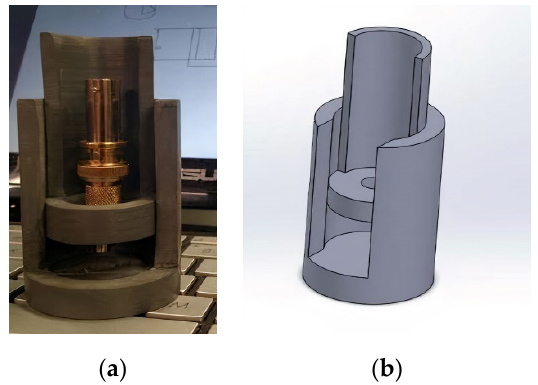
Figure 9. Sample fixture for pulse-echo measurements [14]. ( a ) On left is a photo and ( b ) on the right is the design sketch.